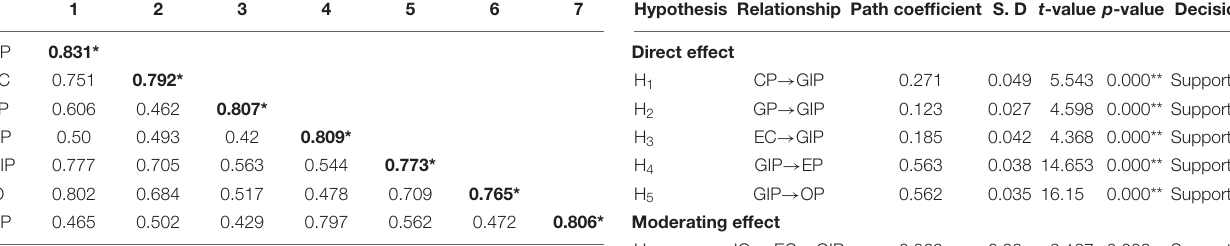
*Bold values represent the square root of average variance extracted (AVE).